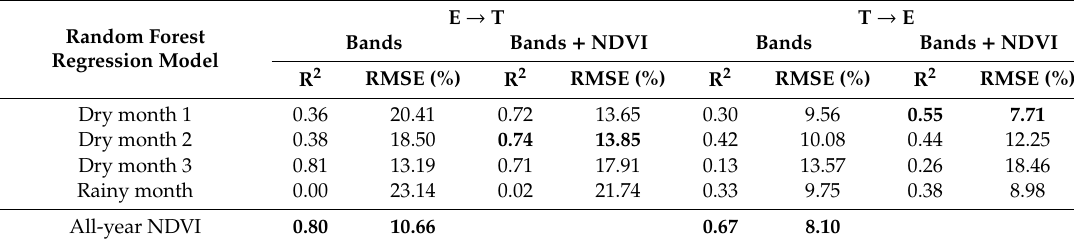
Table A3. R 2 and RMSE of the Random Forest regression for the integrated models including Ethiopia and Tanzania (Scenario 2). E → T indicates that training data are taken from Ethiopia and validated on Tanzania, while T → E indicates training data from Tanzania validated on Ethiopia. The two best performing models for each study site are marked in bold.